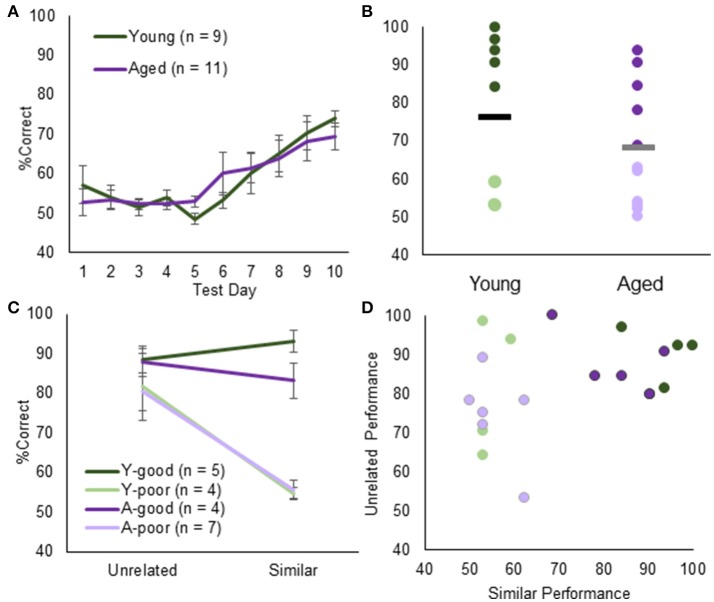
Object discrimination testing and performance. (A) Average % correct for young (green) and aged (purple) animals in discrimination testing. Overall, both groups acquired the task at the same rate. (B) When examining individual rat's performance on Day 10, however, the % correct follows a bimodal distribution across both groups. Using the K-means clustering algorithm, animals were segregated into young-good performers (green), young-poor performers (light green), aged-good performers (purple), and aged-poor performers (light purple). (C) This group division did not extend to either performance on the unrelated object discrimination. (D) Moreover, there was no systematic relationship between unrelated object discrimination and LEGO object discrimination. Therefore, impairments in the LEGO discrimination cannot be explained by procedural or sensorimotor deficits.